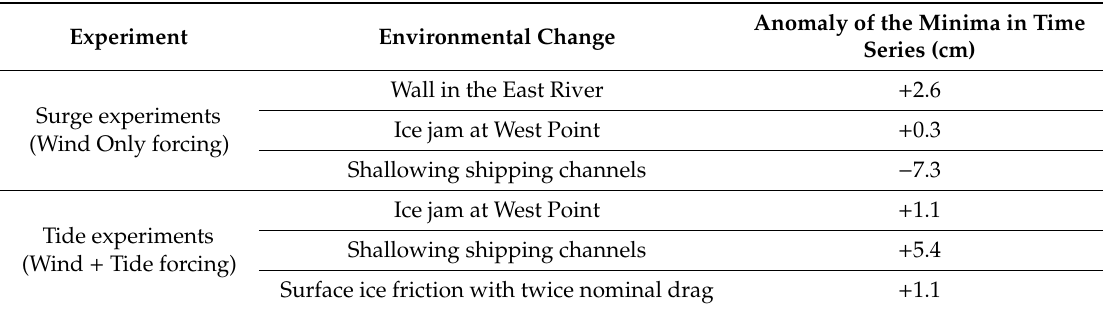
Table 1. Summary of the environmental sensitivity experiments with results for The